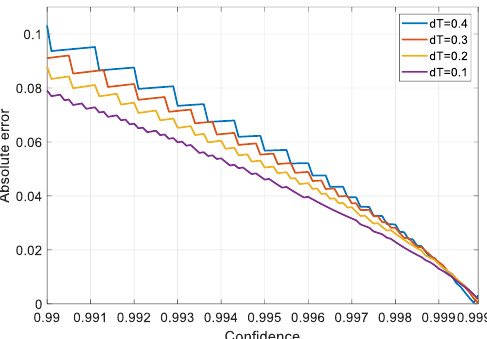
Figure 6. Variation of the absolute expectation error with confidence for TMC.